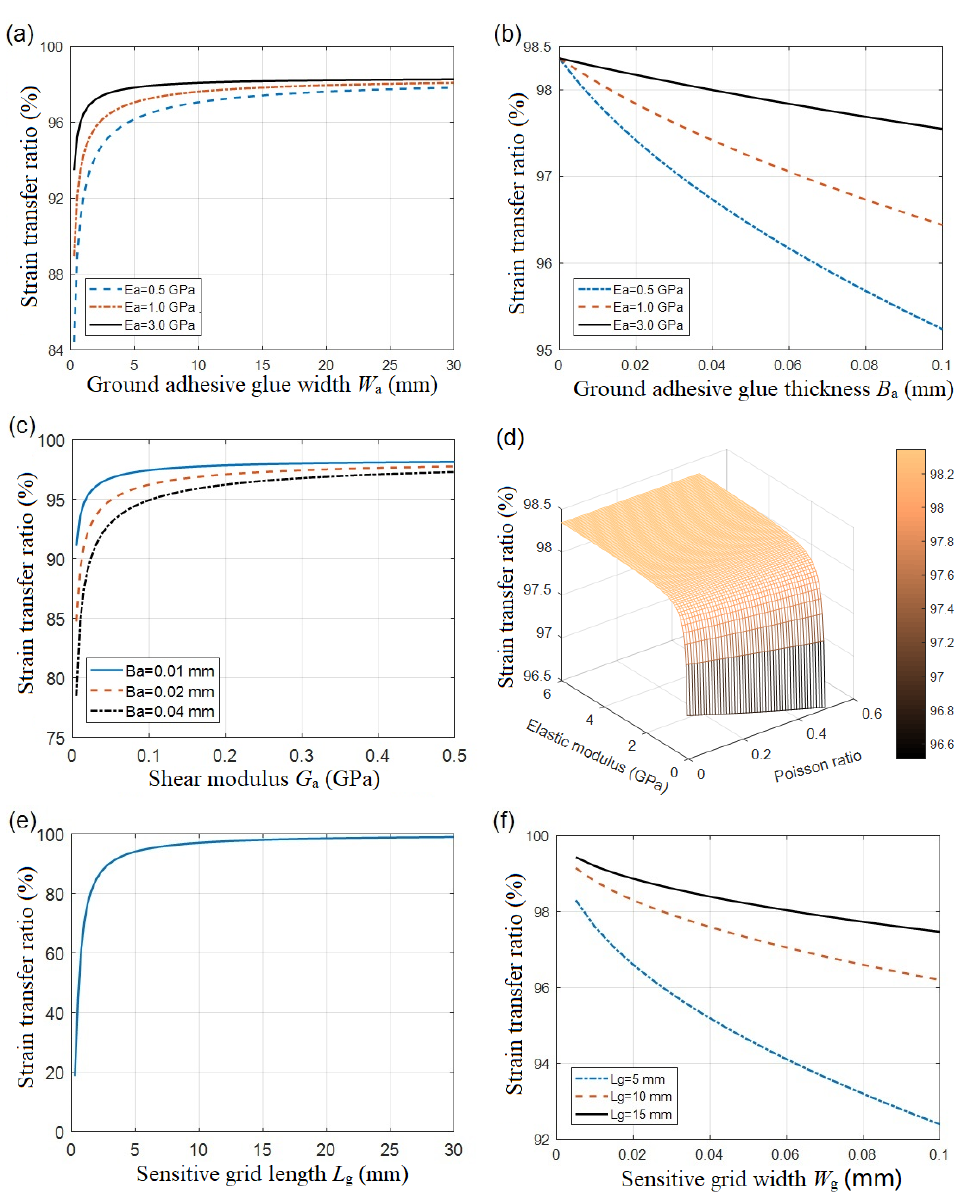
Figure 5. Dependences of the strain transfer ratio on the structural parameters, including ( a ) transverse width of the adhesive layer, ( b ) adhesive thickness, ( c ) shear modulus of adhesive, ( d ) elastic modulus and the Poisson ratio of adhesive, ( e ) sensitive grid length, and ( f ) sensitive grid width.